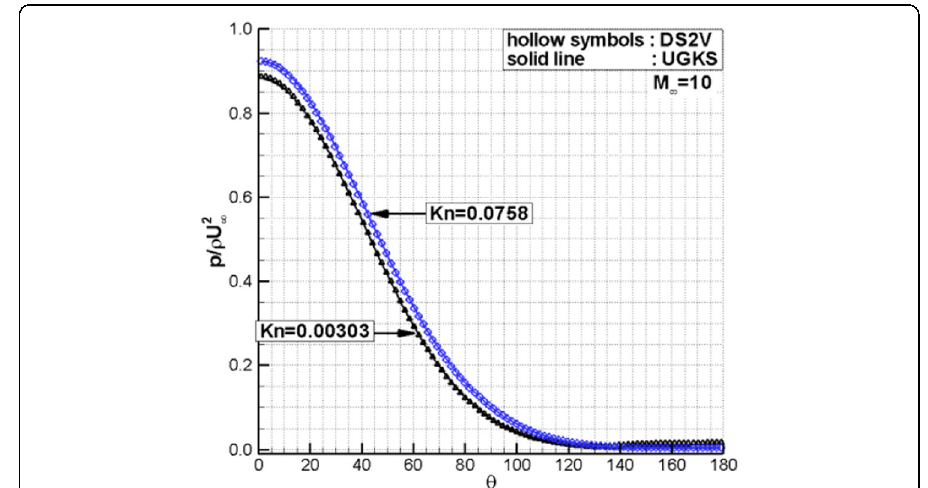
Fig. 18 Pressure distributions on the cylinder surface at M =